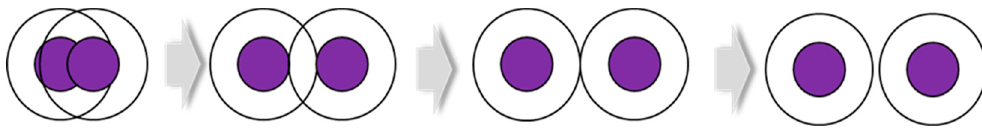
Figure 3. Schematic diagram of the effective range of incident ions.